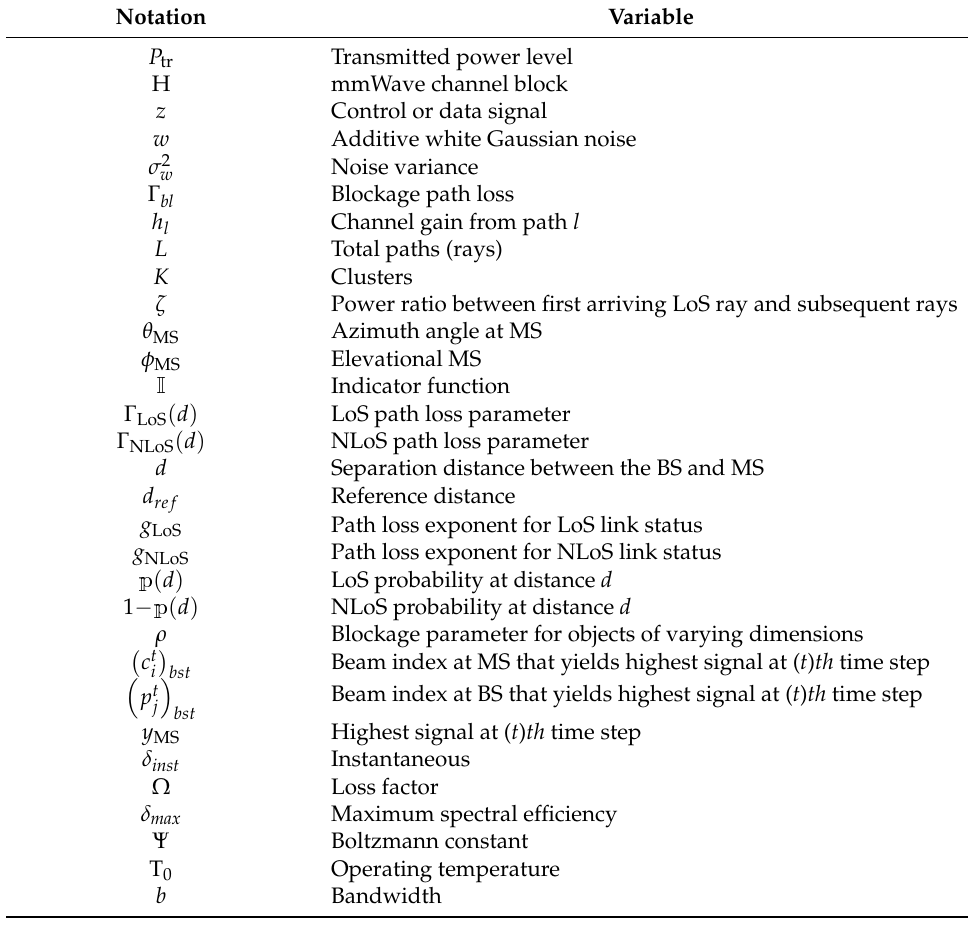
Table 4. List of notations for the mmWave